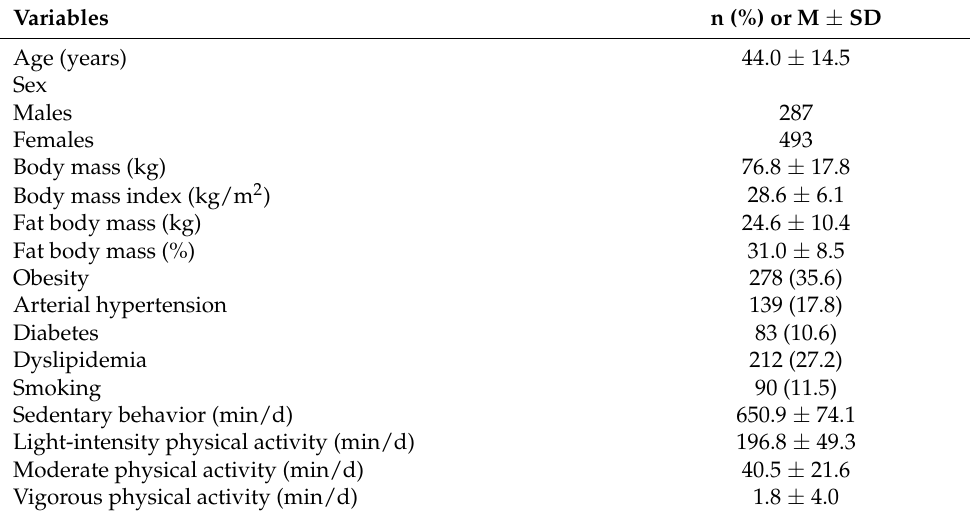
Table 1. General characteristics of the participants analyzed at baseline ( n = 780).